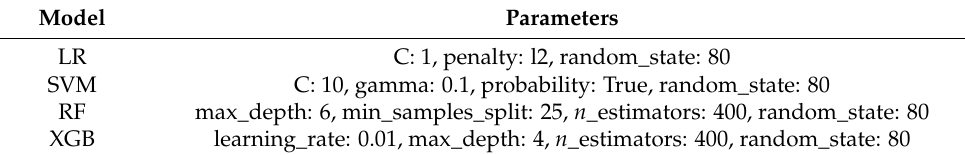
Table 1. Parameters for each machine learning model are selected through the grid